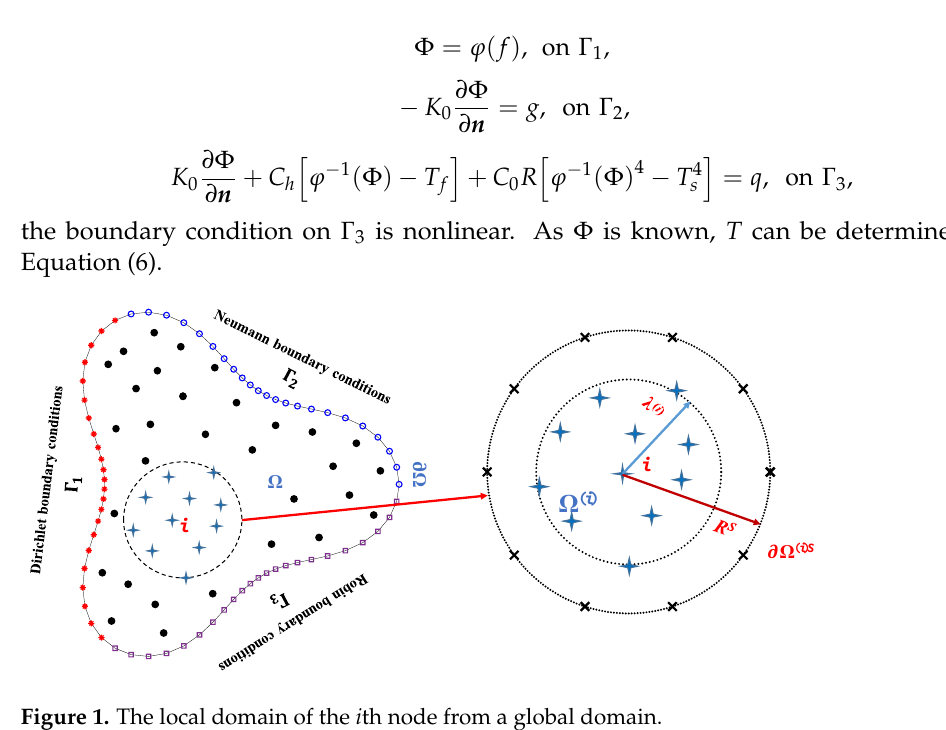
Figure 1. The local domain of the i th node from a global domain.